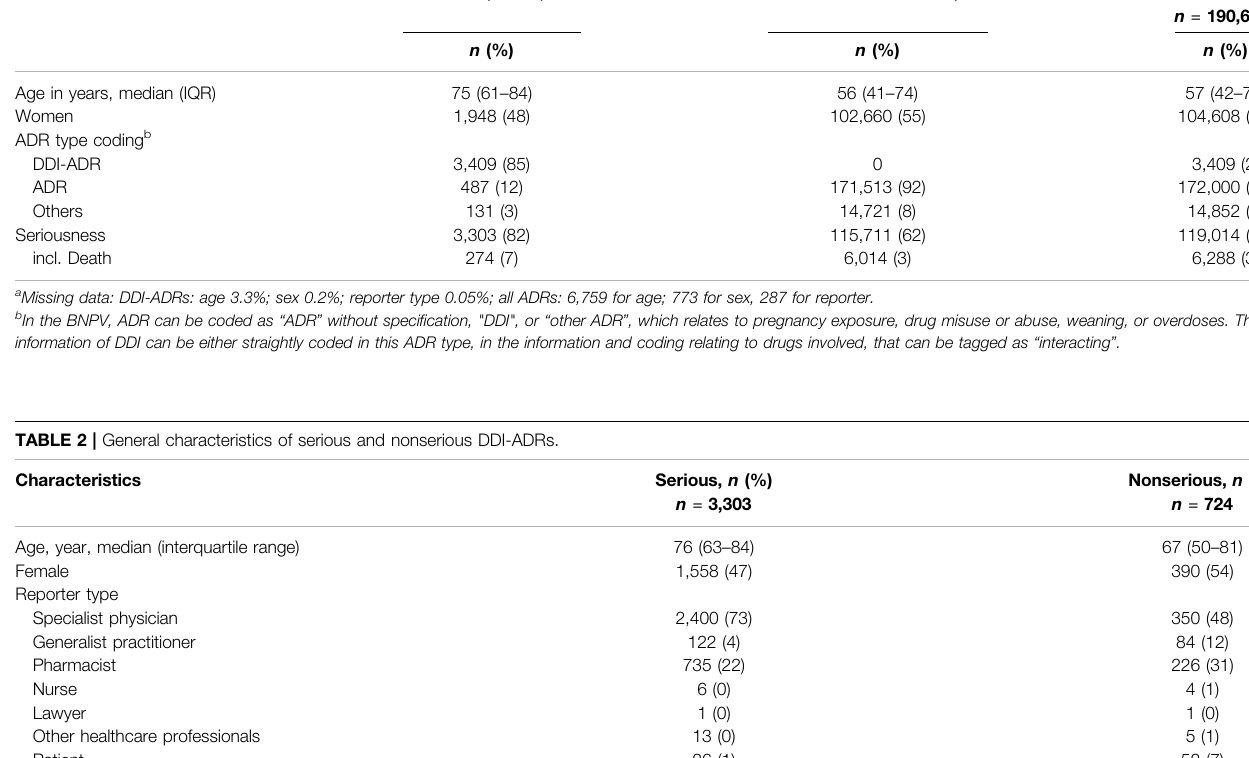
TABLE 1 | General characteristics of the ADR reports considered as DDI and of the ADR reports not relating to identi fi ed DDIs entered in the French Pharmacovigilance Database during the 2012 – 2016 period. Characteristics